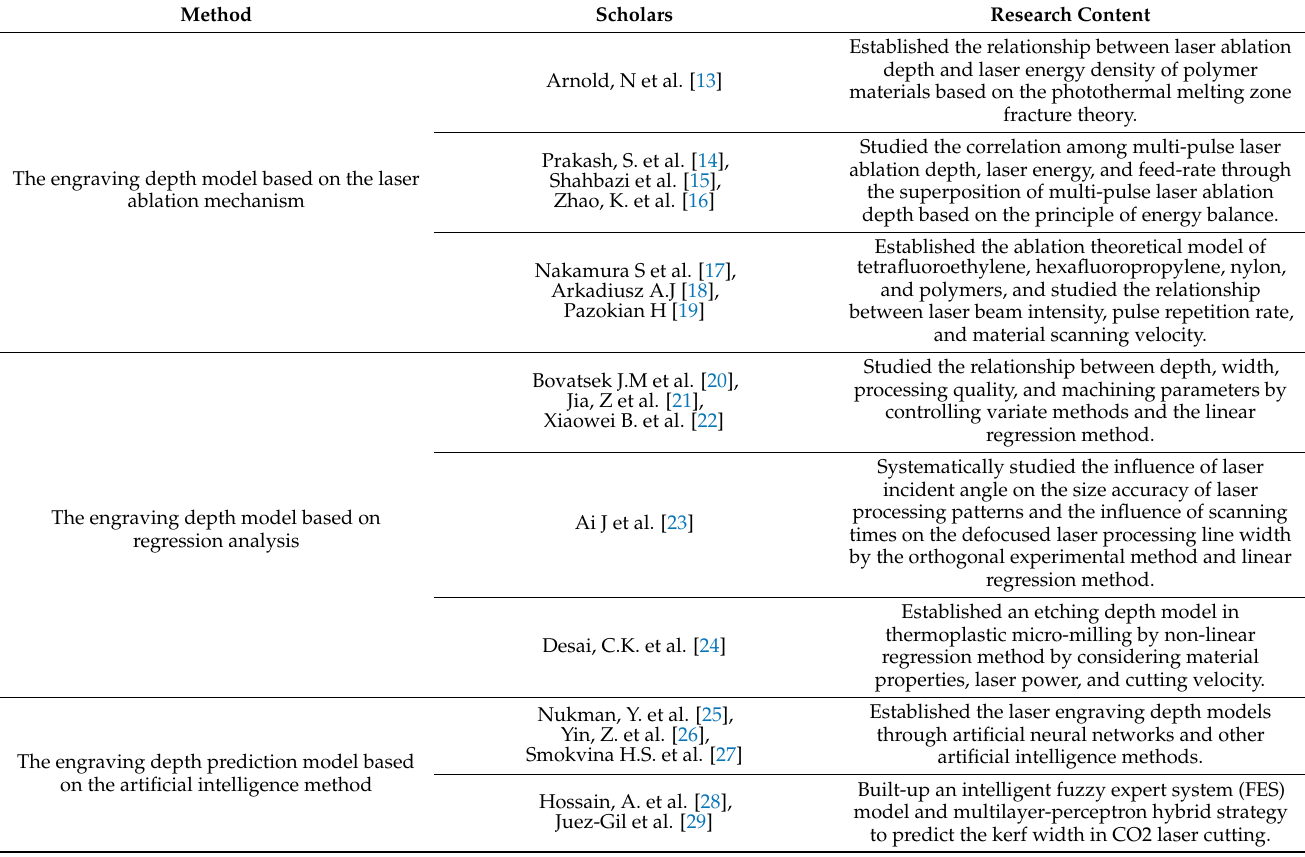
Table 1 . The research status of engraving depth models. Table 1. The research status of engraving depth